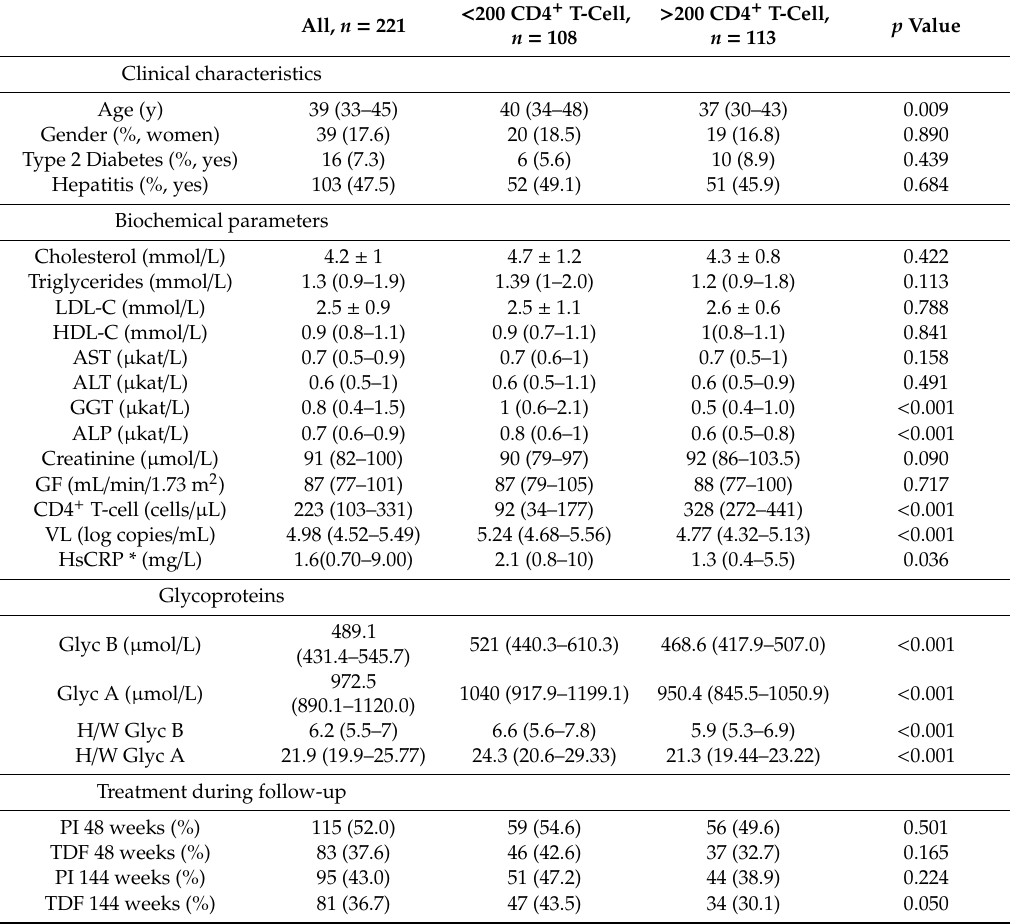
Table 1. Clinical and analytical characteristics of the study subjects. 1 H-NMR glycoproteins at